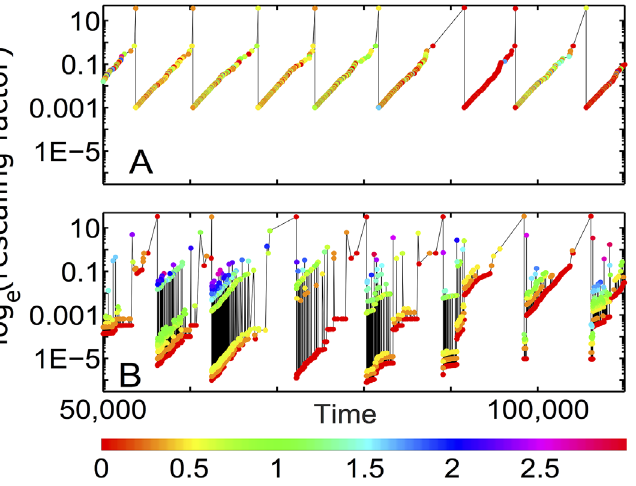
Fig 5. Memory of population size distribution is preserved across several diversity waves. Time course of jumps − log[1 − P collapsed ( t )] in the logarithm of surviving populations following a collapse of a substantial population P collapsed ( t ) > 10 − 10 in A) the simplified model in which at the start of each wave all populations are set equal to each other; B) our basic model. Both were simulated at N = 1000 and γ = 10 − 20 . Note that our basic model, unlike its simplified counterpart, preserves memory of population sizes distribution across several subsequent diversity waves. This is manifested e.g. in similar fractal structure of jumps sizes in waves #2-6 shown in panel B). Colors of symbols (see colorbar below) represent the log 10 of the number of substantial populations during the the previous wave, when a given population originated at the small size γ . Thus red dots mark populations originated at the very end of the previous wave, while yellow dots — those originated when there were two large populations left in the previous wave. Finally, green, blue, and purple dots refer to older populations in the previous